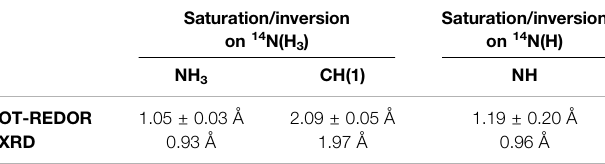
TABLE 3 | 1 H- 14 N distances measured by OT-REDOR and XRD on AlaAla. Saturation/inversion on 14 N(H 3 )